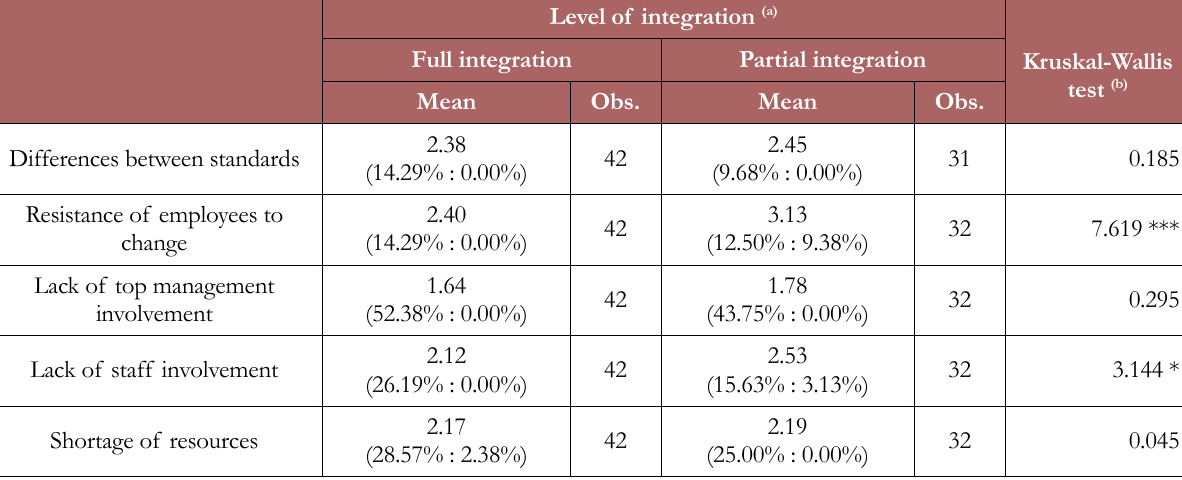
Table 2. Kruskal-Wallis test: Difficulties according to the integration level